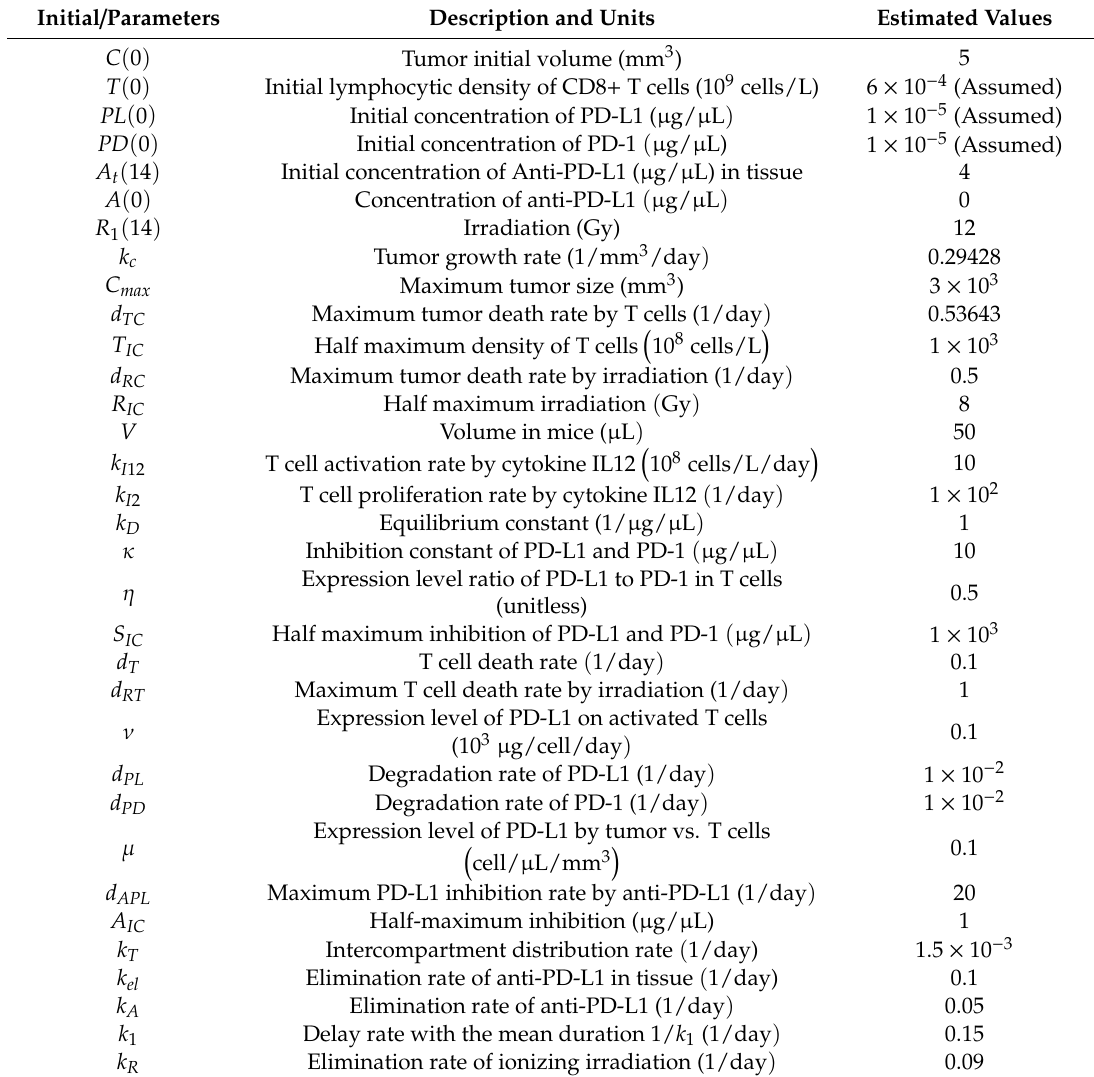
Table 2. Estimated parameters and initial values used in the model are presented together with their descriptions and